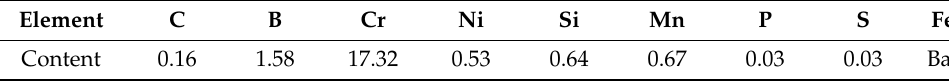
Table 1. Chemical components of boron-bearing stainless steel (wt.%).